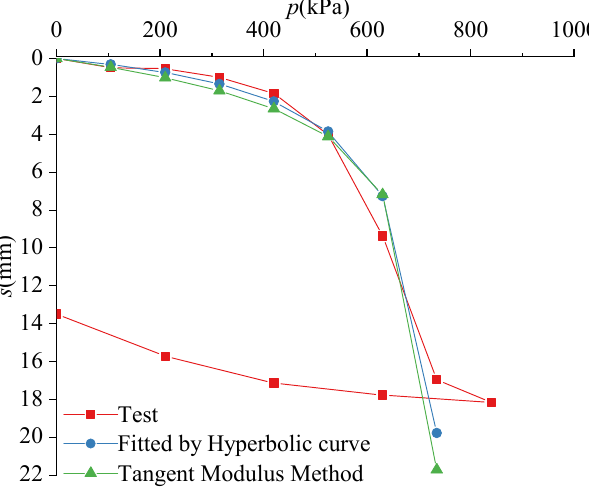
Figure 6. Comparison of p – s curve.